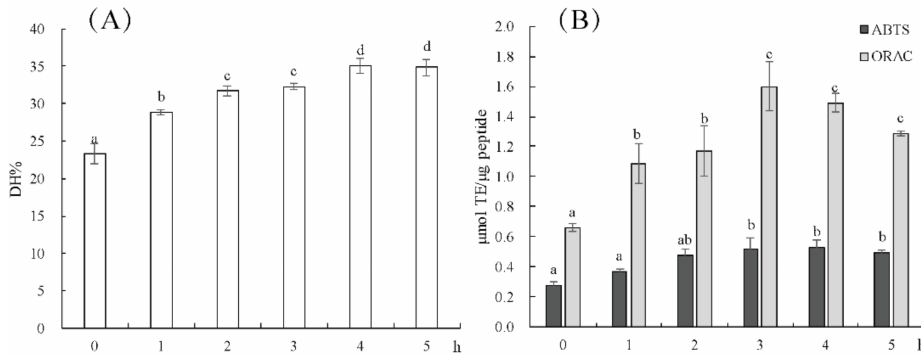
Figure 1. Hydrolysis degree ( A ) and antioxidant activity ( B ) of hydrolysate at different enzymolysis times. Different lowercase letters on the bar indicated significant difference ( p < 0.05) between groups.